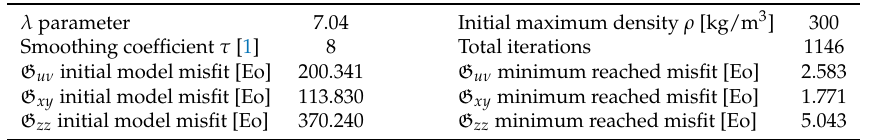
Table 7. Configuration of the gradiometric inversion parameters for the S model.